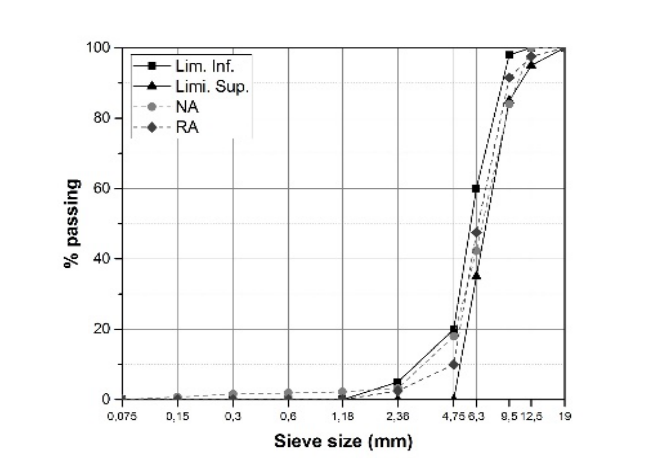
Figure 2. Size distribution of natural and recycled coarse aggregate. NA = Natural Aggregate. RA = Recycled